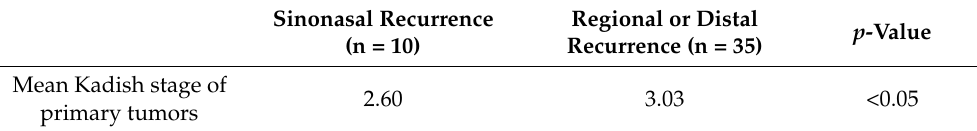
Table 4. Mean Kadish stage between sinonasal recurrence and non-sinonasal